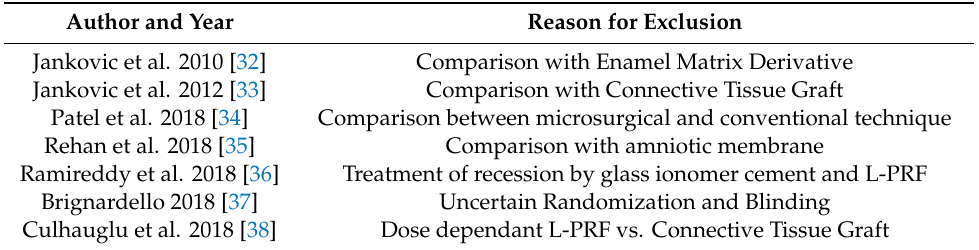
Table 3. List of excluded studies.